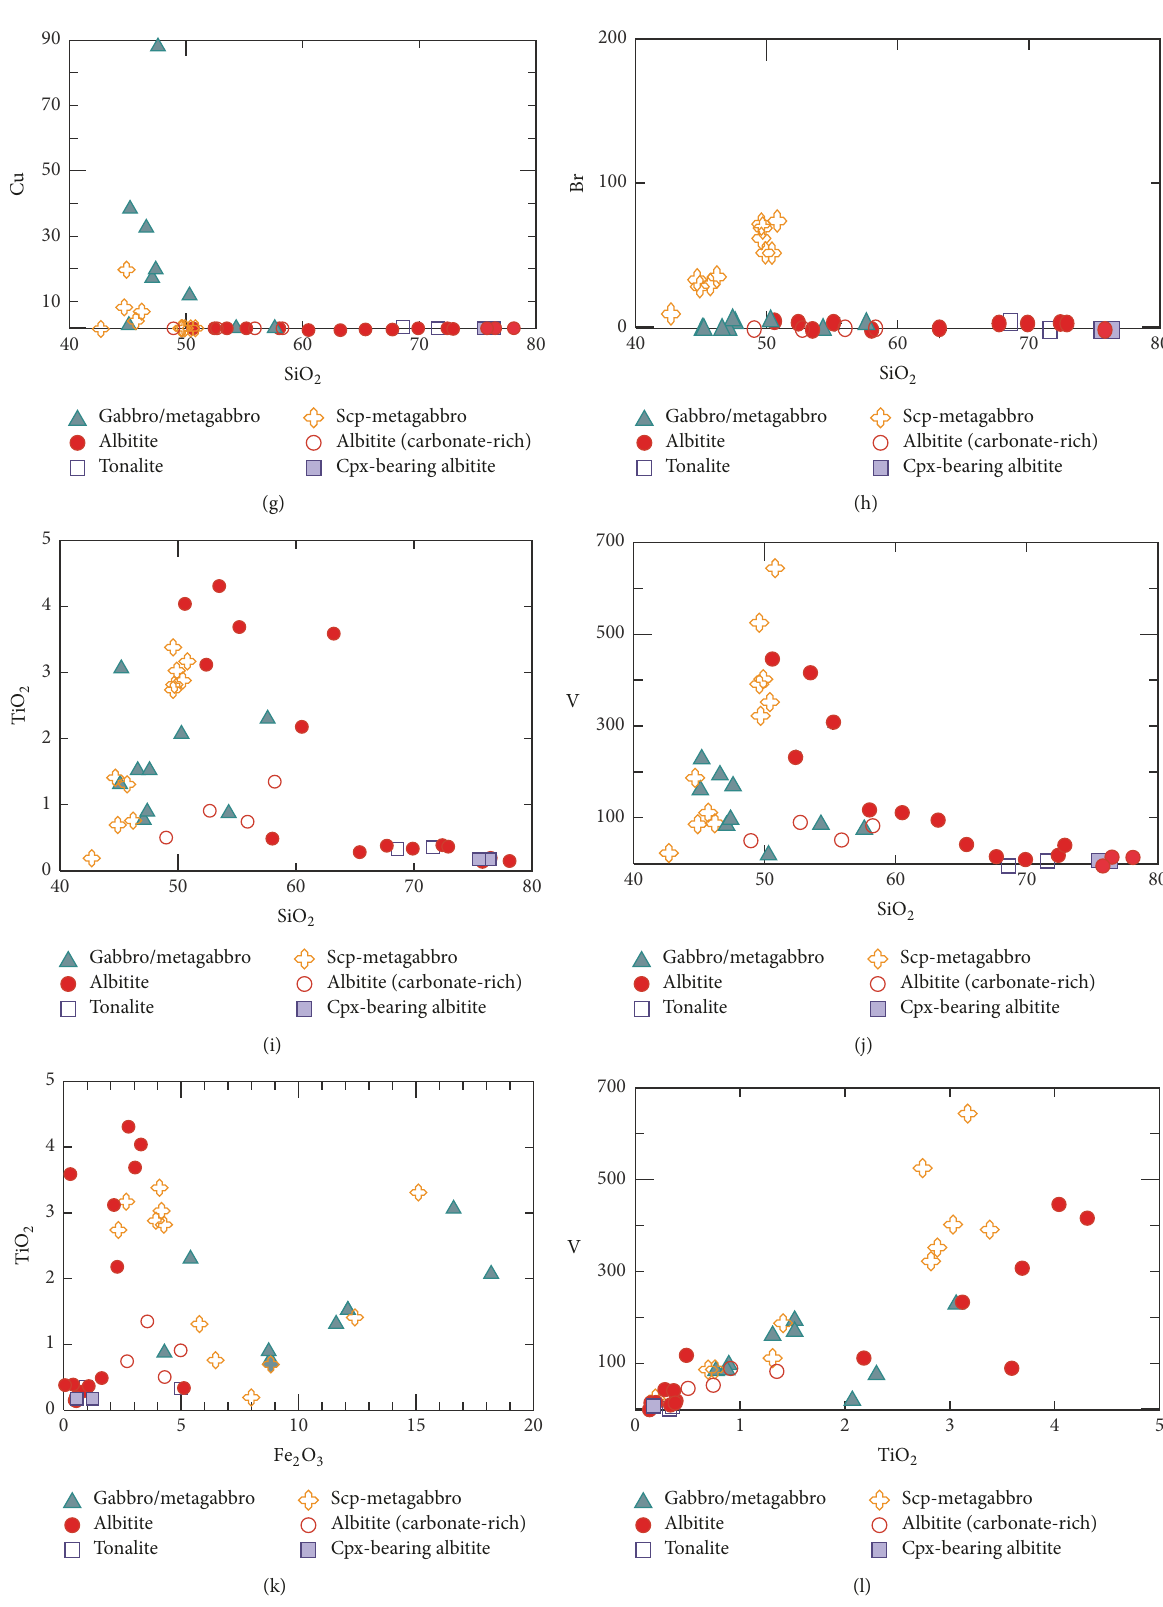
Figure 5: Plots of whole rock geochemical data: (a) Na 2 O-SiO 2 ; (b) CaO-SiO 2 ; (c) Fe 2 O 3 -SiO 2 ; (d) MgO-SiO 2 ; (e) P 2 O 5 -SiO 2 ; (f) Zn-SiO 2 ; (g) Cu-SiO 2 ; (h) Br-SiO 2 ; (i) TiO 2 -SiO 2 ; (j) V-SiO 2 ; (k) TiO 2 -Fe 2 O 3 ; and (l) V-TiO 2